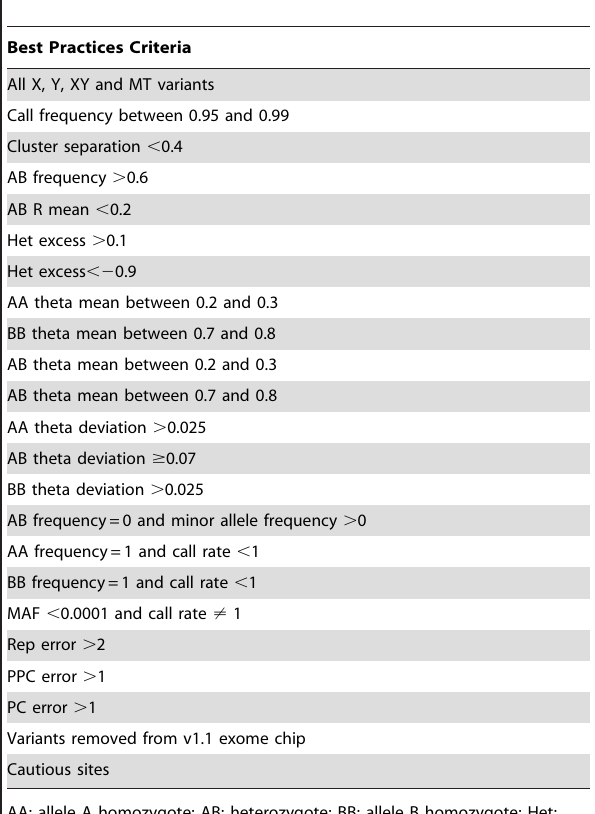
Table 5. Exome chip SNP exclusion criteria. Exclusion Criteria